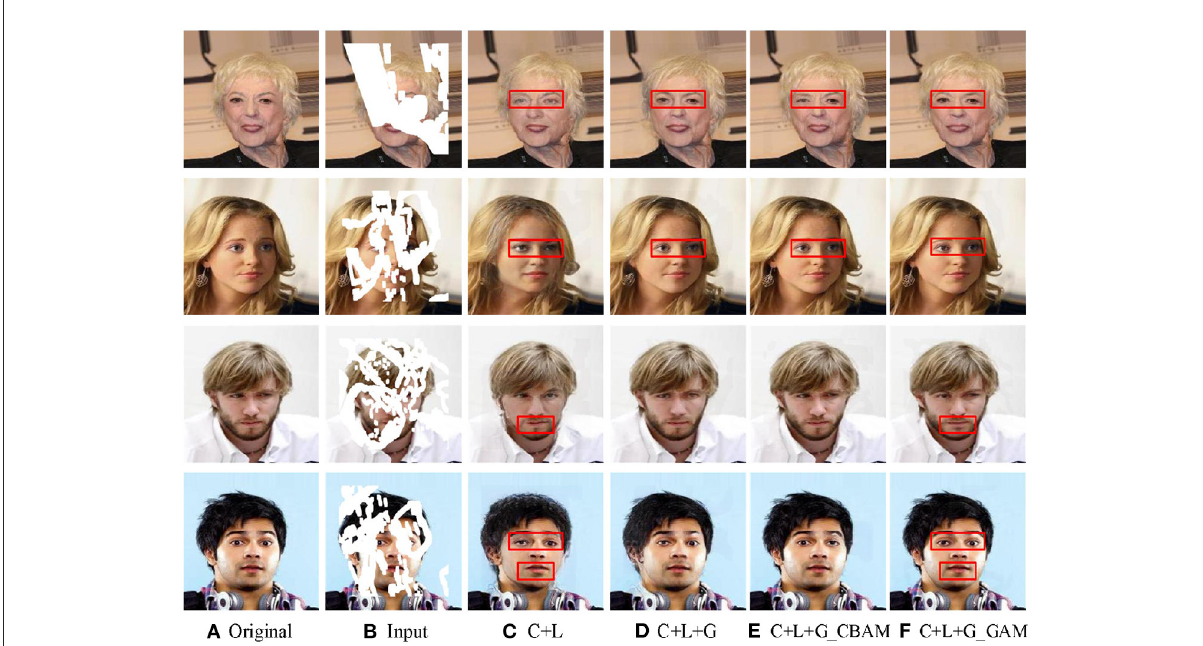
FIGURE10 The outputs of different network frameworks with different attention mechanisms. Here “ C ” indicates a crude inpainting network, “ L ” means a local refinement network, and “ G ” means a global refinement network without any attention mechanism. “G_CBAM” means a global refinement